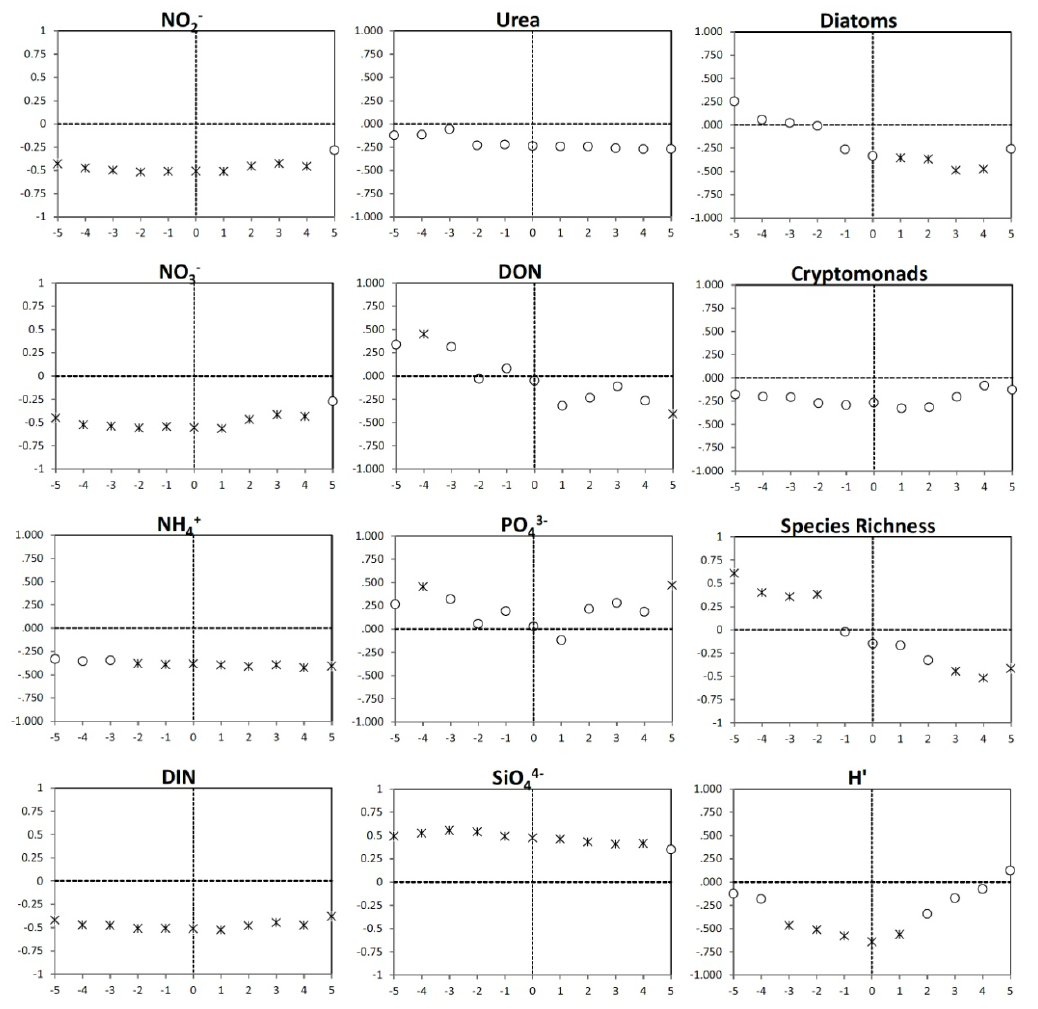
Figure 8. Time lag Pearson correlation plots of dinoflagellate abundance versus nutrient concentrations, diatom abundance, cryptomonad abundance, phytoplankton species richness and diversity (Shannon index H ′ ). Periods of plus or minus five days are shown on the X -axis with 0 being present. The Pearson correlation coefficient is plotted on the Y -axis, with positive values indicating positive relationships, and negative values negative relationships. Correlations that are statistically significant at the p < 0.05 level are indicated by